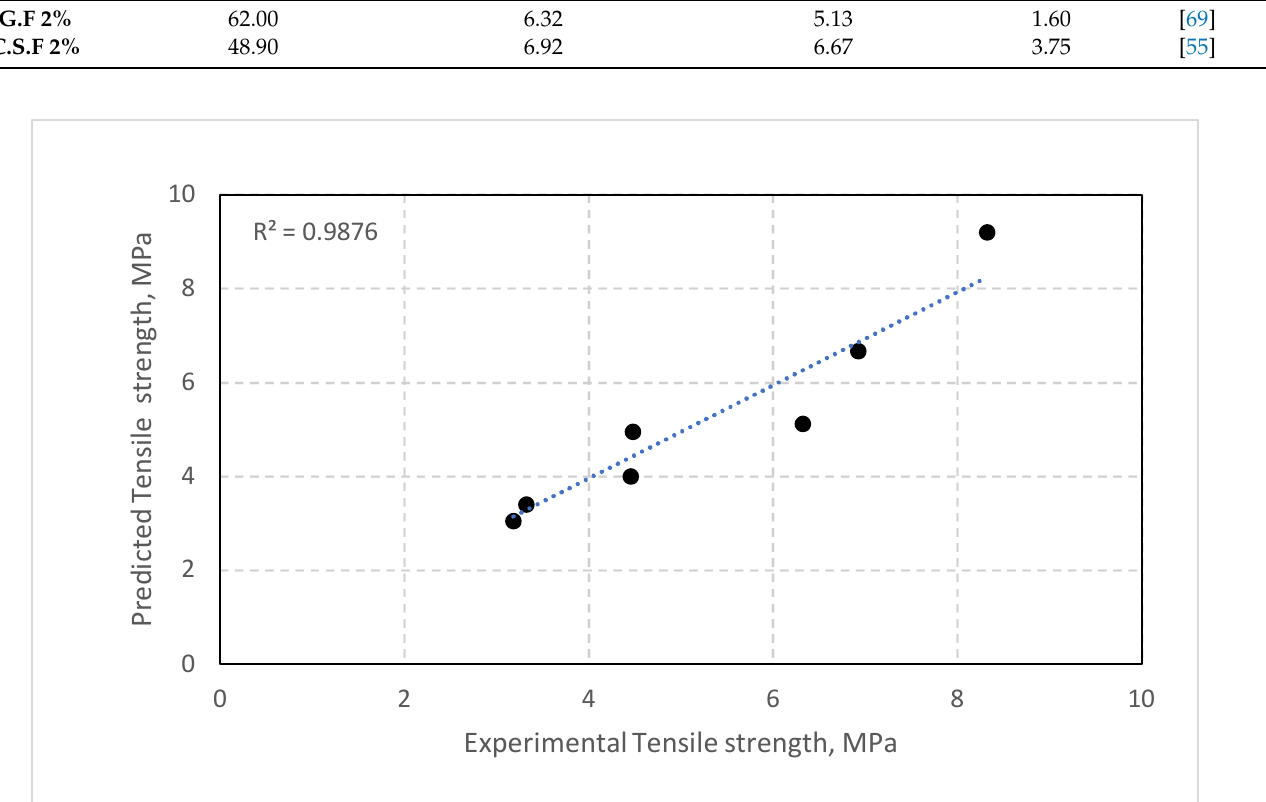
Figure 20. Comparison of predicted splitting tensile strength to experimental tensile strength. Table 7. Values of α factor from the experimental test results.